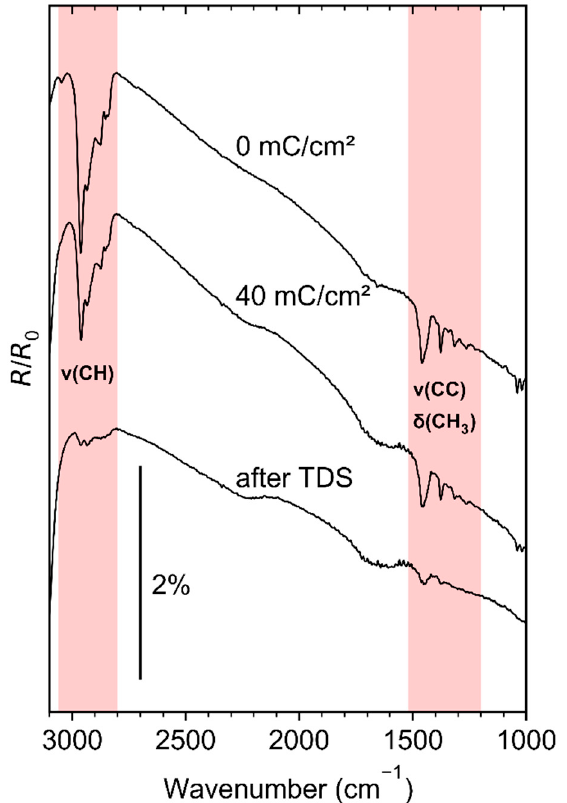
Figure 3. Reflection–absorption infrared (RAIR) spectra of a pristine 7–10 ML (EtCp) 2 Ru film on a Ta substrate held at 110 K directly after precursor dosing (0 mC / cm 2 ), after electron irradiation at E 0 = 31 eV (40 mC / cm 2 ), and after a subsequent TDS run to 450 K. A RAIR spectrum acquired from the clean Ta sheet just before (EtCp) 2 Ru dosing served as a background for all spectra shown here. The infrared spectrum of the precursor shows two major regions of signals (marked in red): Aliphatic and aromatic C–H stretches ( ν (CH)) between 2800 and 3100 cm − 1 and aliphatic and aromatic C–C stretches ( ν (CC)) as well as bending vibrations of the terminal –CH 3 groups ( δ (CH 3 )) between 1200 and 1500 cm − 1 [31].